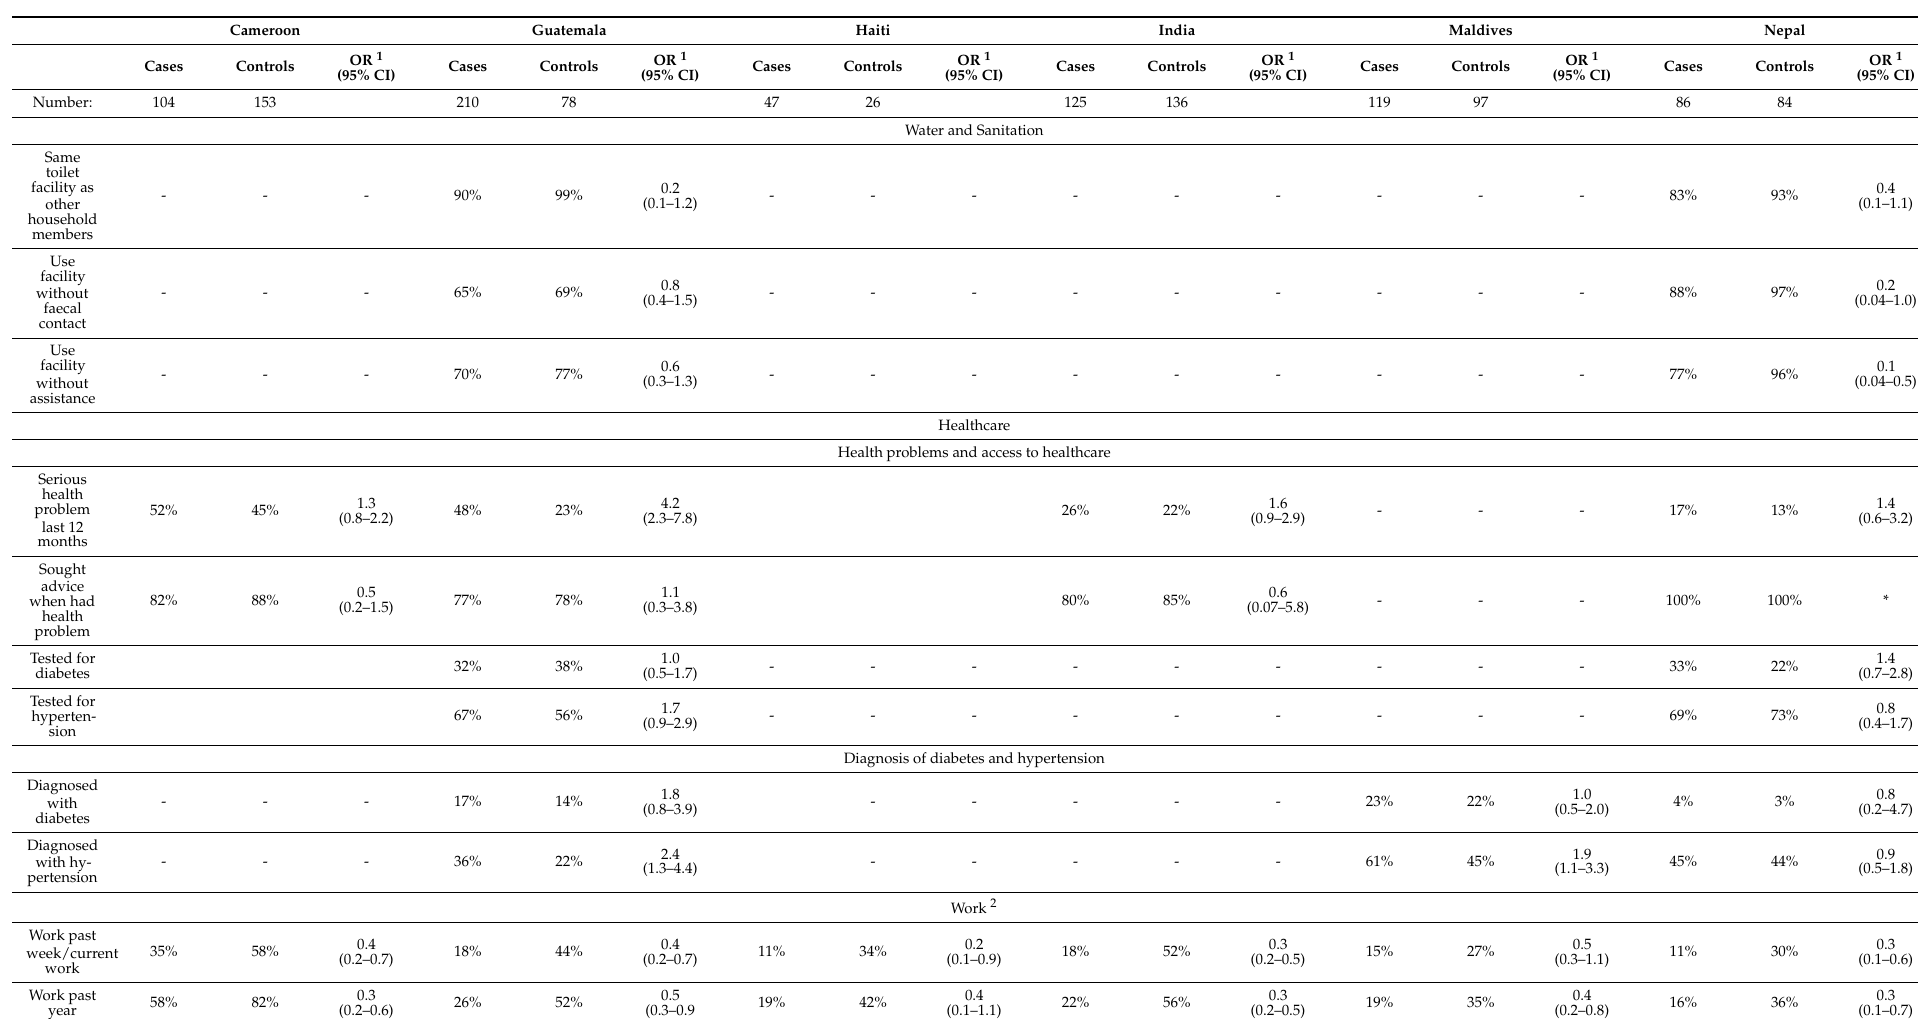
Table 3. Comparison of older people with disabilities (‘cases’) and without disabilities (controls) in hygiene, health and healthcare and work. Cameroon Guatemala Haiti India Maldives